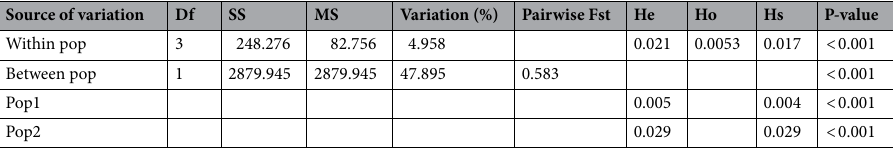
Table 2. Analysis of molecular variance (AMOVA), and genetic variation within and among populations. DF degree of freedom, SS sum of squares, MS expected mean squares, % percentage of the variance, He expected heterozygosity, Ho observed heterozygosity. P -value: significance tests after 1000